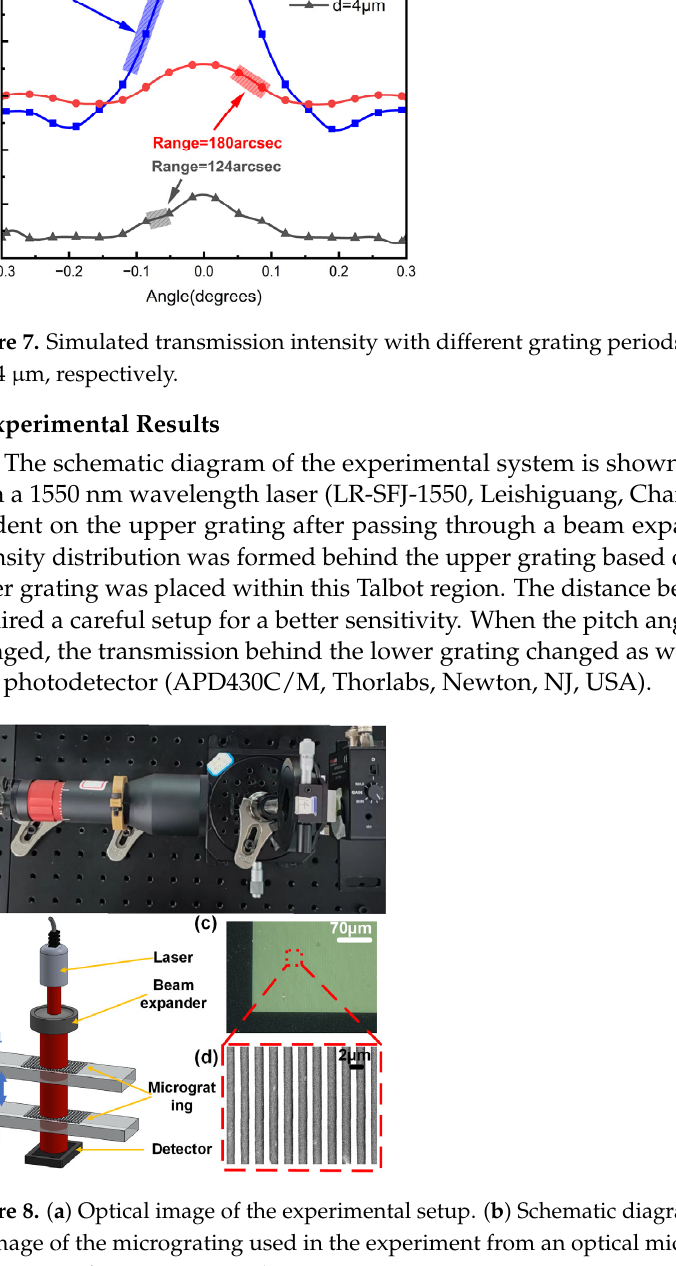
Figure 6. Simulated transmission intensity with different numbers of grating lines in which N was 100, 150 and 200, respectively.